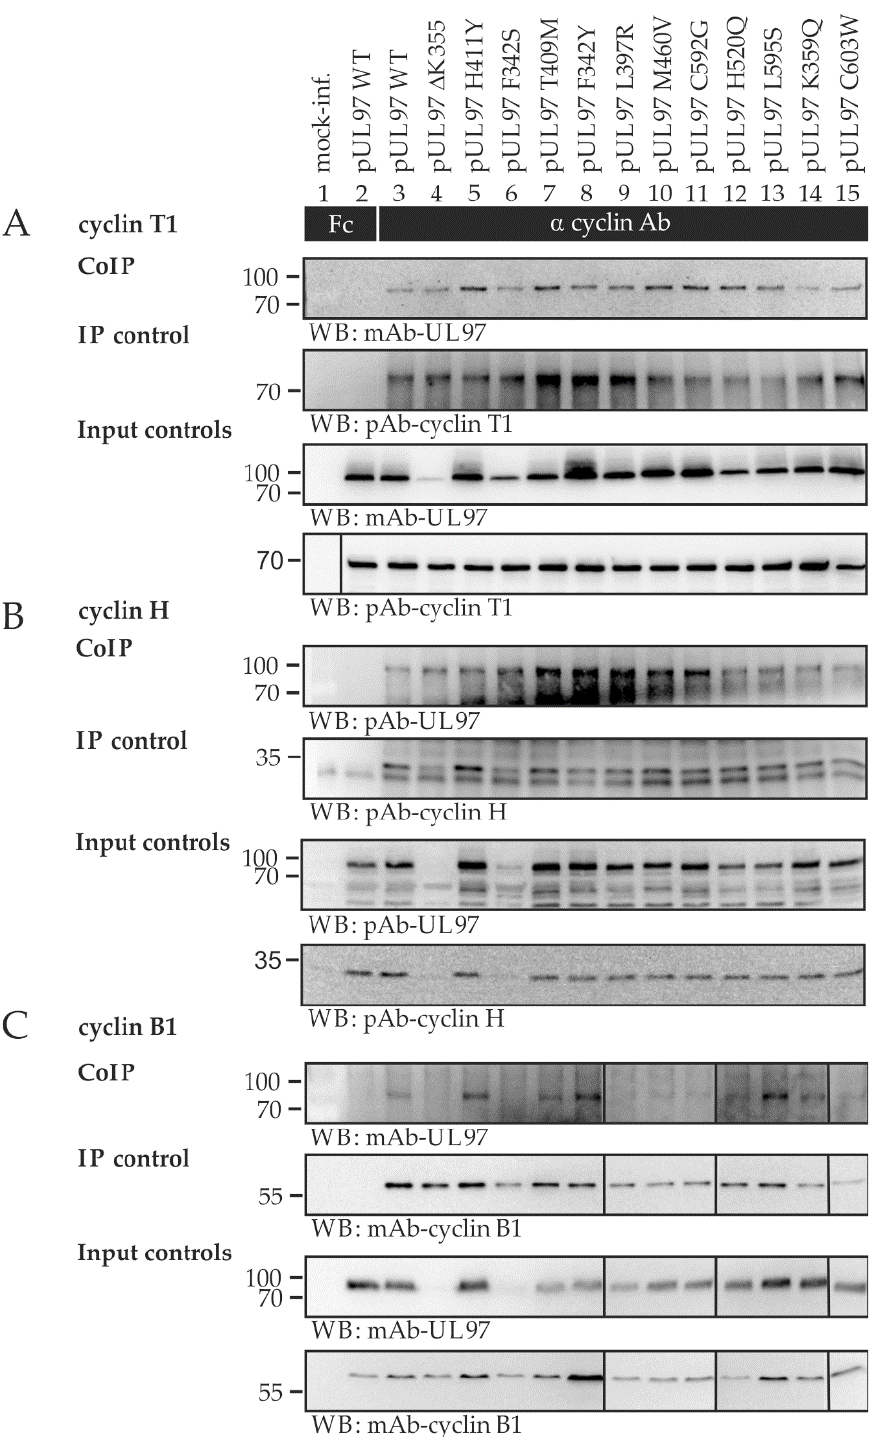
Figure 4. Interaction analysis of AD169 pUL97 resistance mutants with human cyclins. HFFs in T75 flasks were infected with HCMV AD169 WT or UL97 point mutants (UL97 WT and mutants were derived from Sunwen Chou, Portland, OR, USA). Cells were harvested between 4 and 7 d.p.i., when approx. 80% of the cells showed a cytopathic effect. Cells were lysed, and human cyclins T1 ( A ), H ( B ), and B1 ( C ) were immunoprecipitated using specific antibodies. A chicken Fc fragment served as specificity control, and lysate taken prior to immunoprecipitation was used as input control. All samples were subjected to Wb analysis, and proteins were detected using the specific monoclonal and polyclonal antibodies indicated.